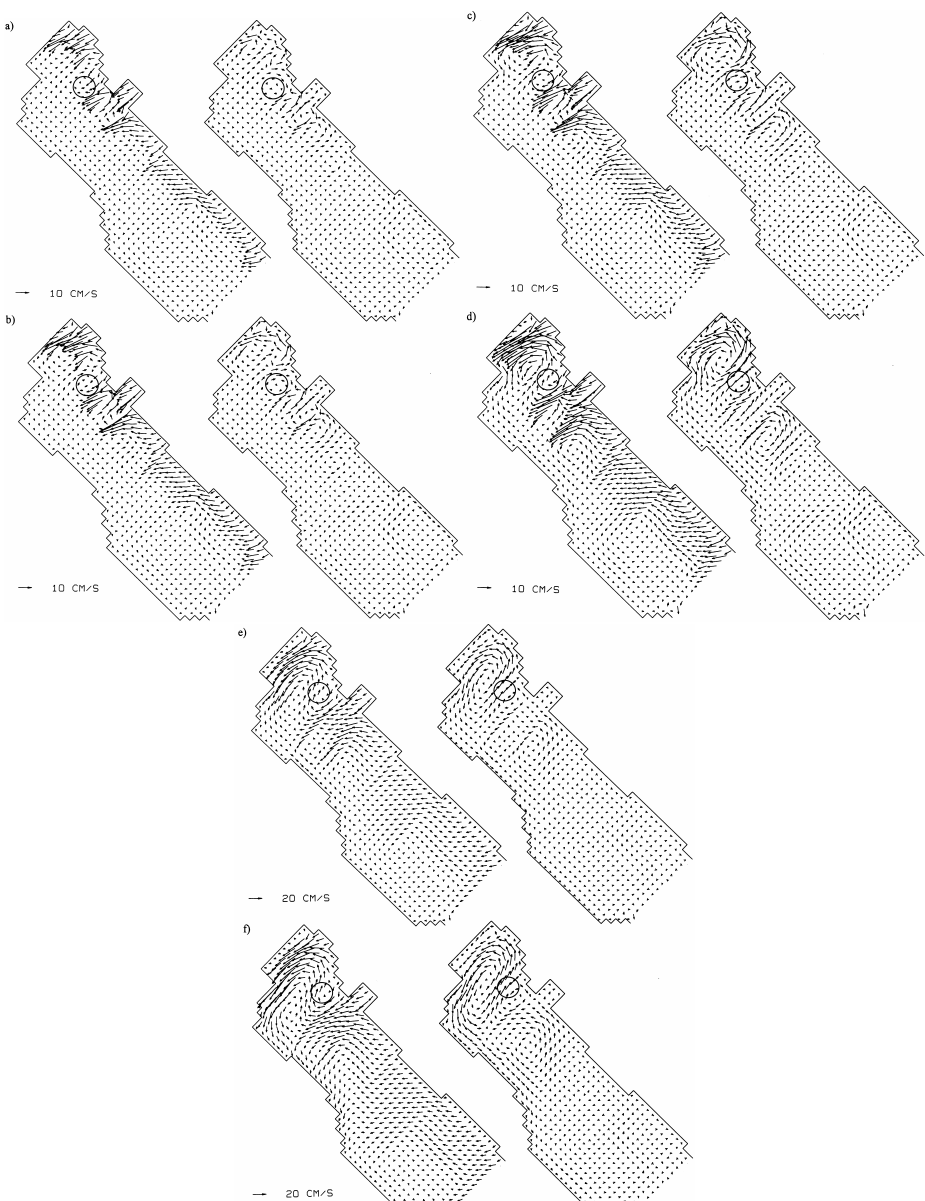
Fig. 3. Surface currents (left) and currents at the seventh sigma level (right) obtained from the numerical experiments assuming a bora range of 30km ( a ) , 40km ( b ) , 50km ( c ) , 70km ( d ) , 100km ( e ) and 150km ( f ) and a climatological profile calibrated to 10m/s at the Pula meteorological station. The gas field Ivana is denoted by a